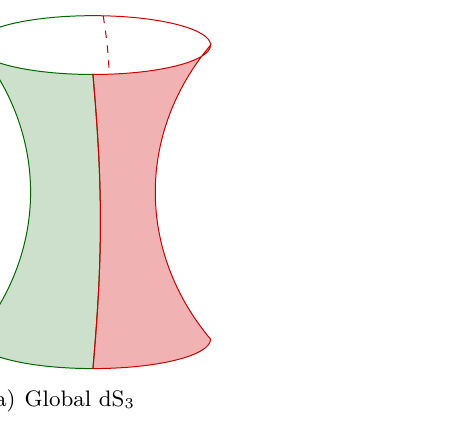
Figure 1 . Global de Sitter is the surface of the hyperboloid (a). Time flows upwards; one angular coordinate is suppressed, such that each time-slice is actually a two-sphere (b). We split the spacetime into two, reducing over the red part to get JT gravity on dS 2 . The green part is the remainder of dS 3 , which takes on the role of the